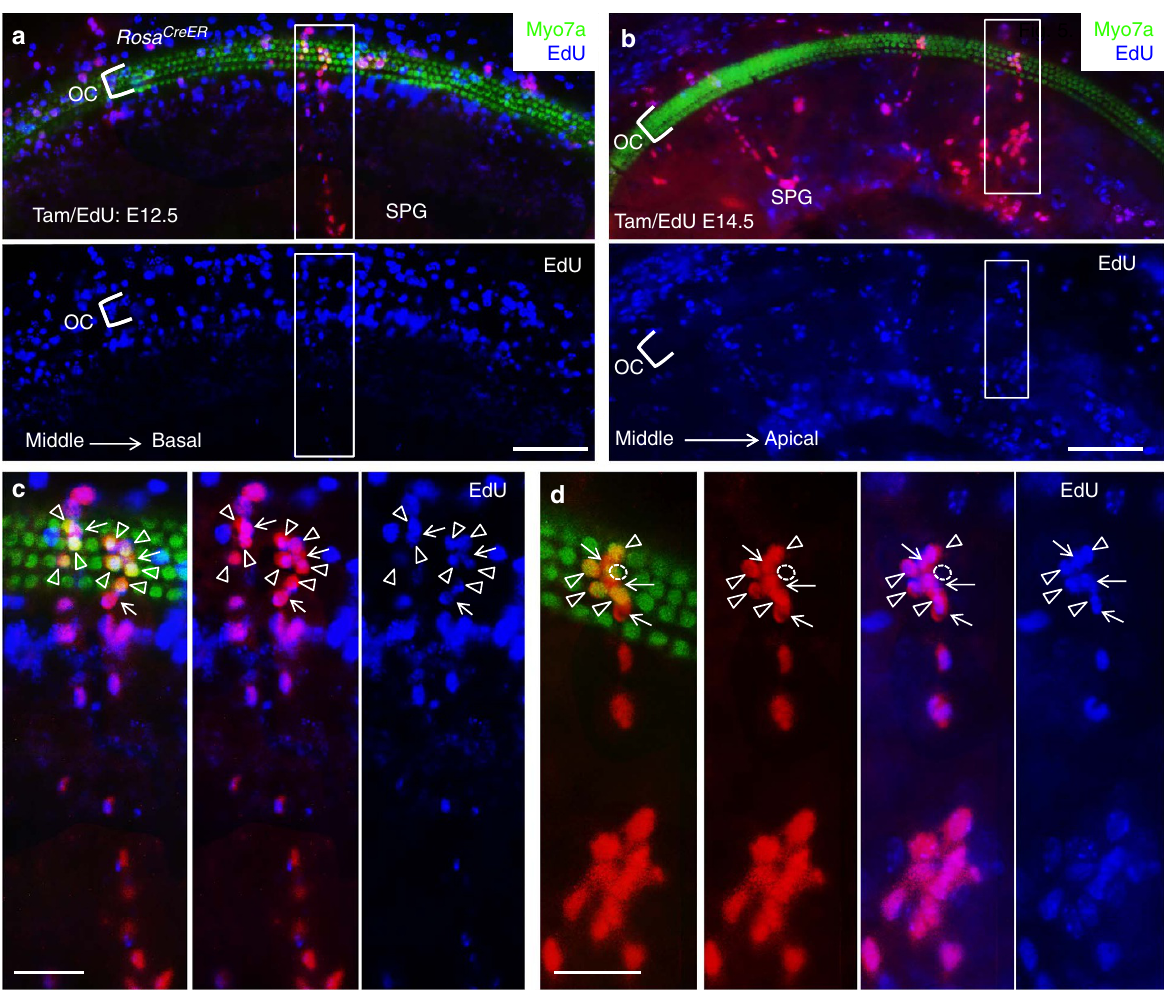
Figure 5 | Clonal and mitotic analysis in E18.5 cochlea. Rosa CreER ;Rainbow mice were co-injected tamoxifen (2mg) and EdU. ( a , b ) Cochlea (middle turn) from E12.5 Rosa CreER ;Rainbow ( a ) or E14.5 Eya1 CreER ;Rainbow ( b ) stained with anti-Myo7a (green) and EdU (blue). ( c , d ) Higher magnification of boxed area in a , b , respectively. All marked cells within a clonal cluster of 4 20 cells that consists of Myo7a þ HCs (open arrowheads) and surrounding Myo7a (cid:2) SCs (arrows) as well as cells in spiral ganglion region (SPG) are EdU-labelled cells. Circle (dashed line) represents an unmarked hair cell. Scale bars: 100 m m ( a , b ); 30 m m ( c , d